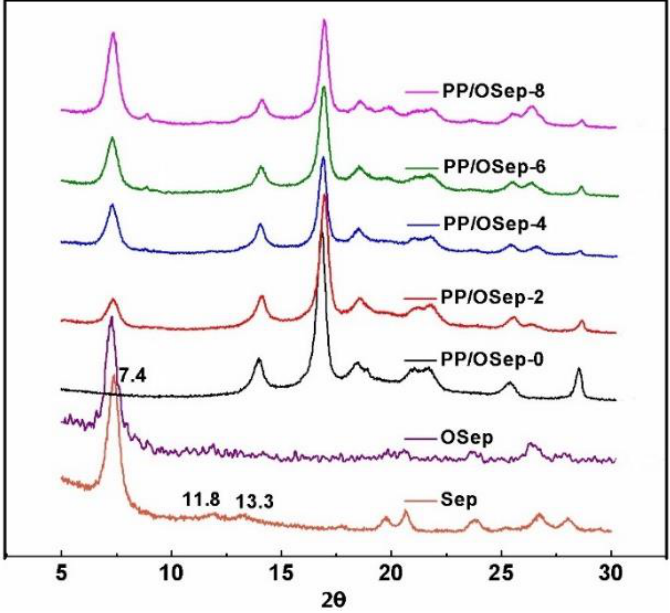
Figure 9. XRD patterns of Sep, Osep and PP/OSep nanocomposites.